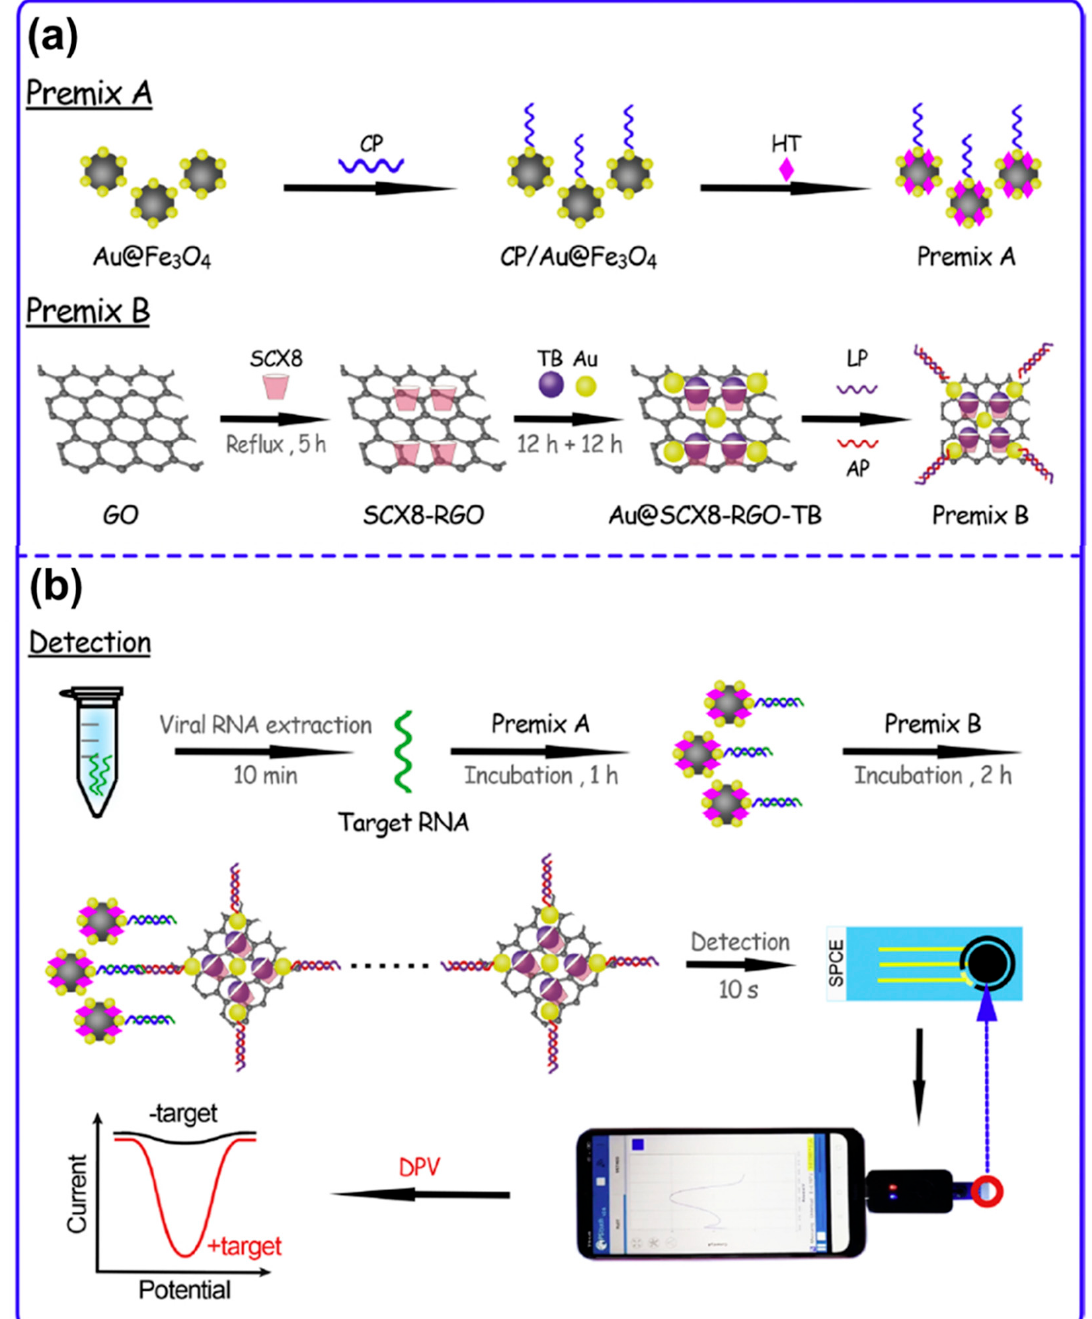
Figure 22. Schematics for the fabrication of a plug-and-play super-sandwich electrochemical immunosensor for 2019-nCoV. ( a ) shows the synthesis of Premix A and B. ( b ) combining Premix A with 2019-nCoV RNA and preparation of the super-sandwich for the detection 2019-nCoV through a smartphone [296]. Reprinted with permission from [296], Copyright © 2020 published by Elsevier